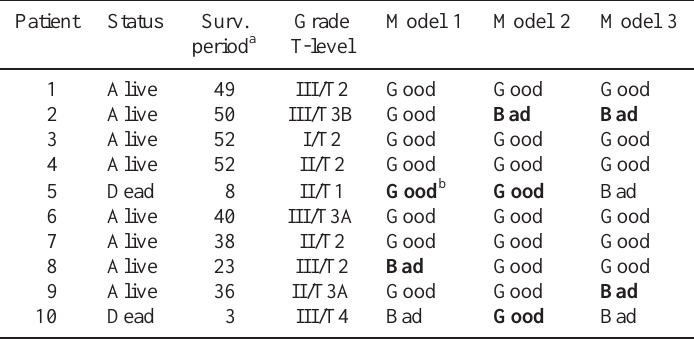
Table 5 Patients’ status predicted by three decision tree-related